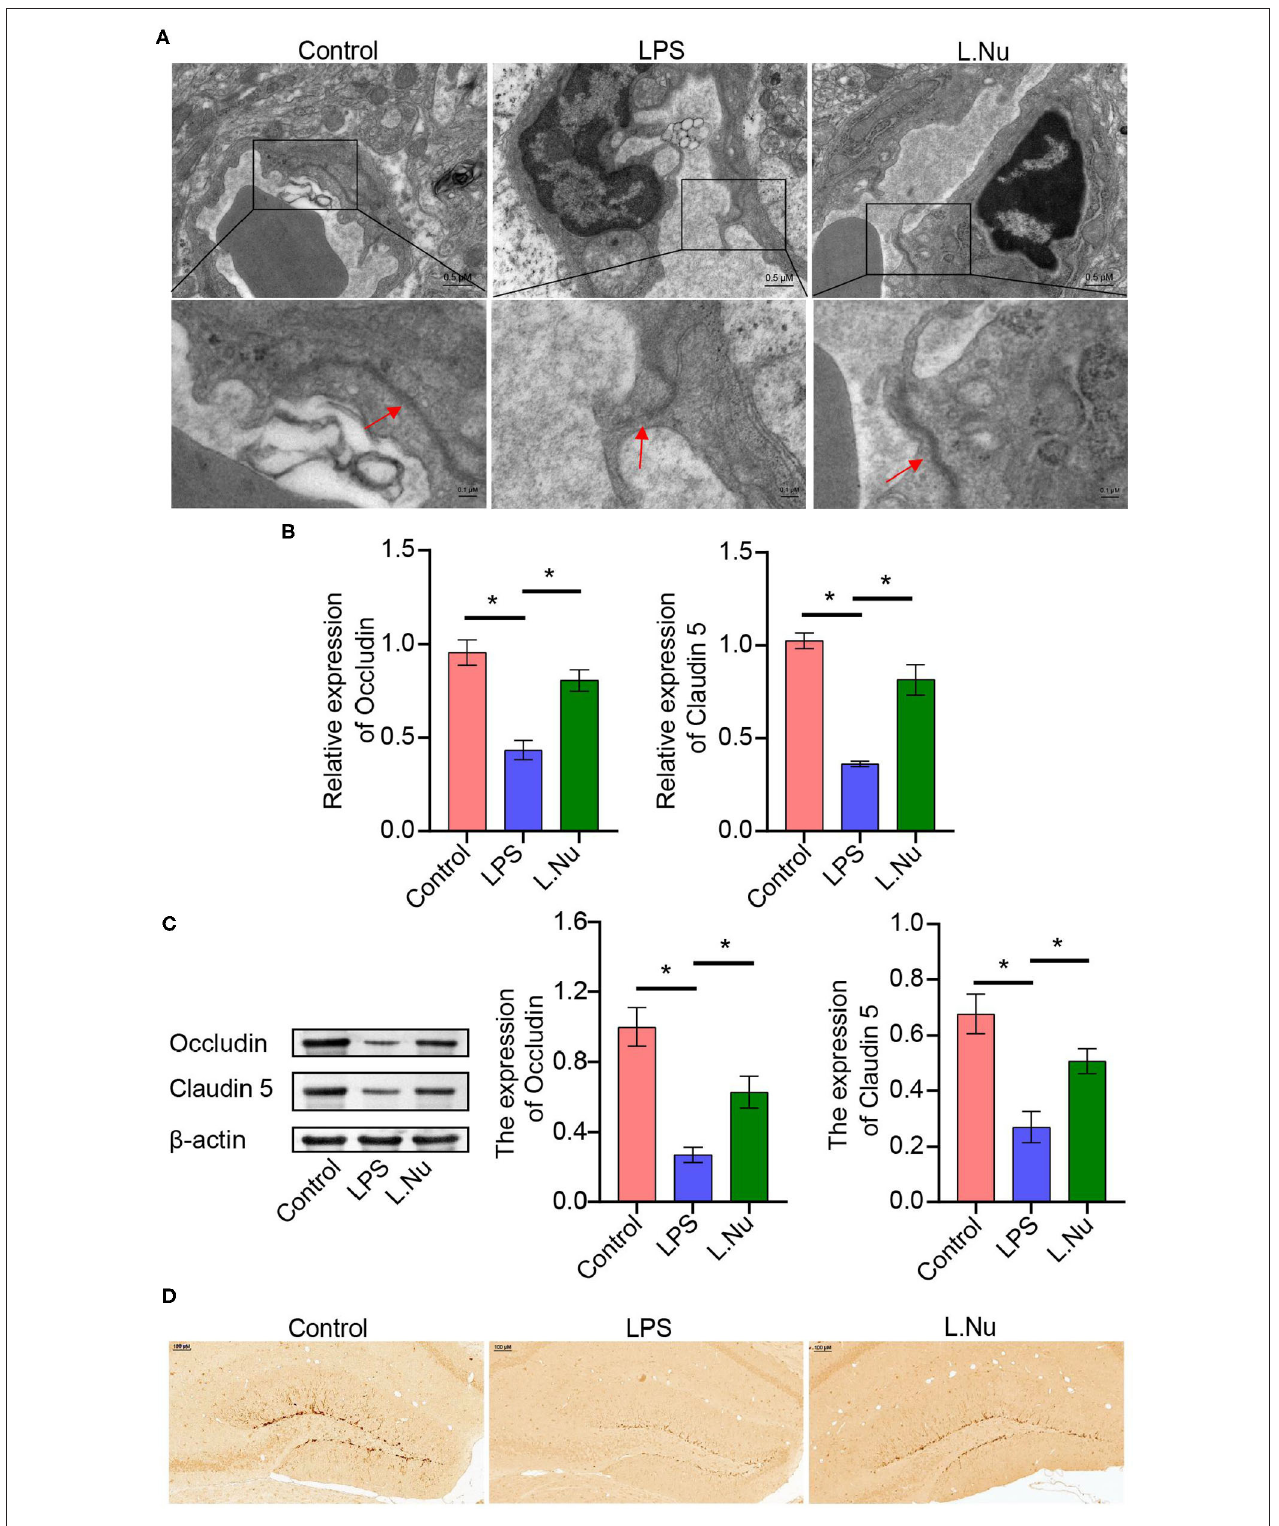
FIGURE 2 | NU9056 protected BBB, and newborn neurons function from damage in vivo. (A) The morphological changes of the tight junctions of the hippocampus in the mice were observed using TEM. The arrow points to a tight junctions structure. (B,C) The expression levels of Occludin and Claudin 5 genes and proteins in the mouse hippocampus were detected using RT-qPCR and Western blot. (D) The DCX expression level of newborn neurons in the brain tissue of mice was observed using IHC. * P < 0.05.